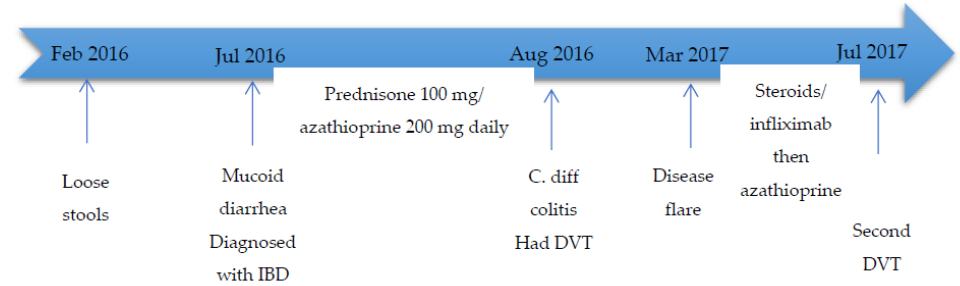
Figure 2. Summary of events for case II. Legends: IBD: inflammatory bowel diseases; C. diff: clostridium difficile; DVT: deep vein thrombosis.